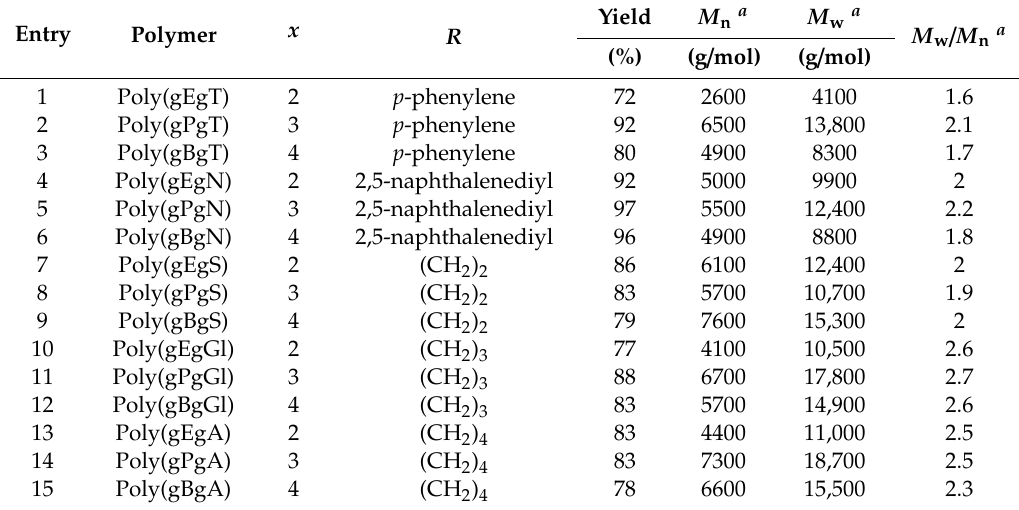
Table 1. Synthesis of sequential poly(ester amide)s.